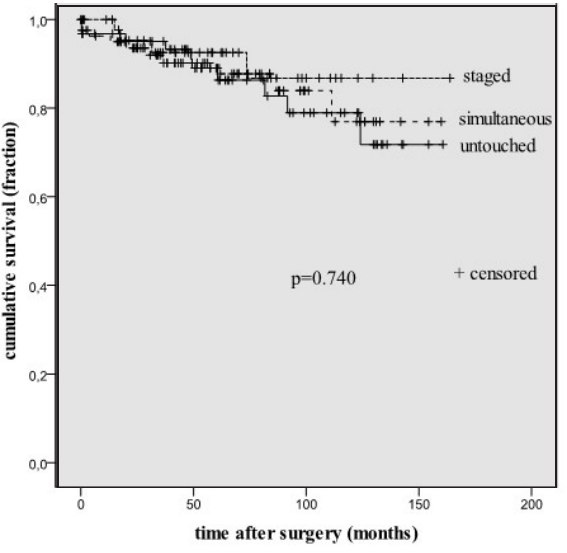
Fig. 3 - Neurological-related event-free survival curves of the groups. Untouched=only coronary artery bypass